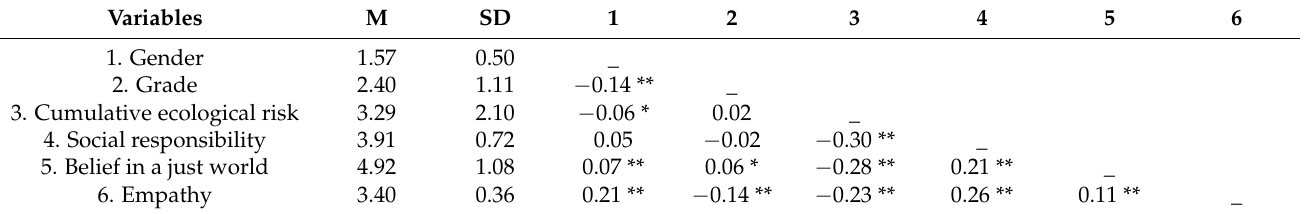
Table 2. Correlation of Means, Standard Deviations, and Study Variables (N =